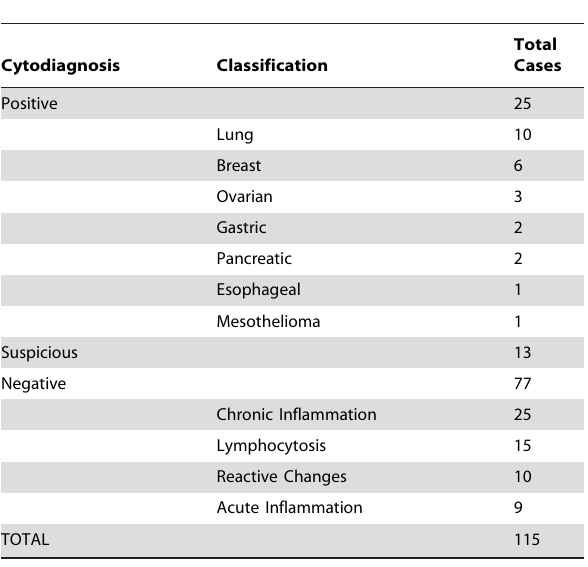
Table 1. Summary of 115 Pleural Samples Analyzed in the